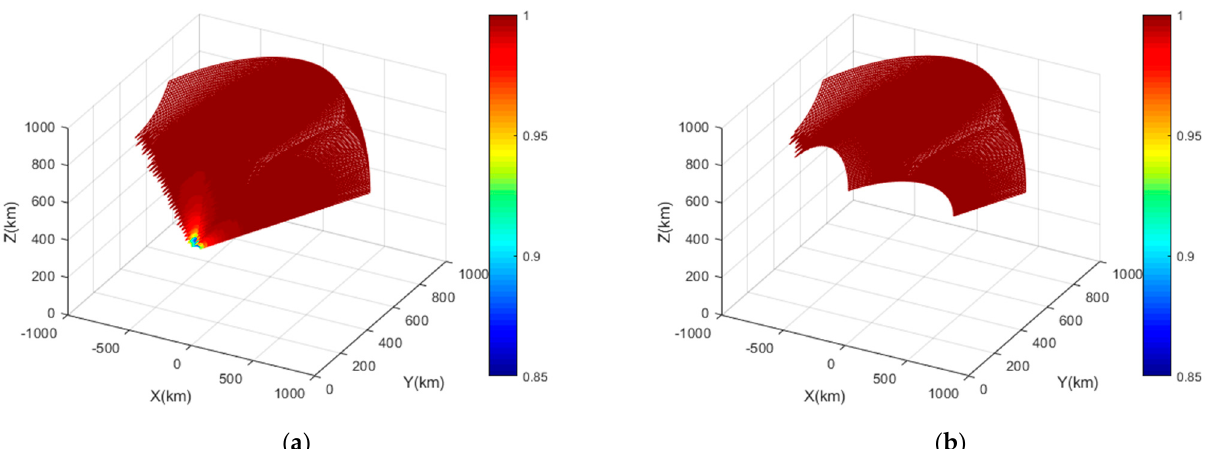
Figure 5. Target coherent integration efficiency map. ( a ) Target coherent integration efficiency under ideal conditions in the whole detection space; ( b ) target coherent integration efficiency with detection range constraints in the whole detection